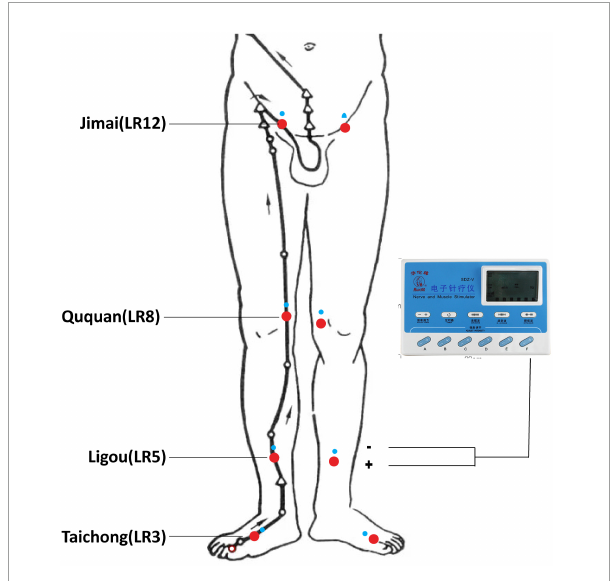
FIGURE1 Locations of selected acupoints. The acupoints were Taichong (LR3), Ligou (LR5), Ququan (LR8), and Jimai